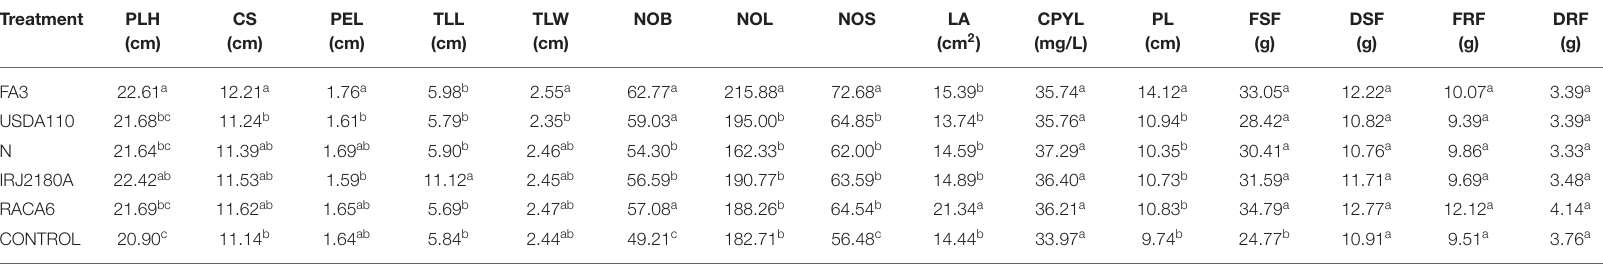
TABLE 3 | Effect of N fertilizer and B. japonicum strains on growth trait and biomass yield of accessions of B. groundnut at 12 WAP in Ibadan and Ikenne in the first season, 2019.